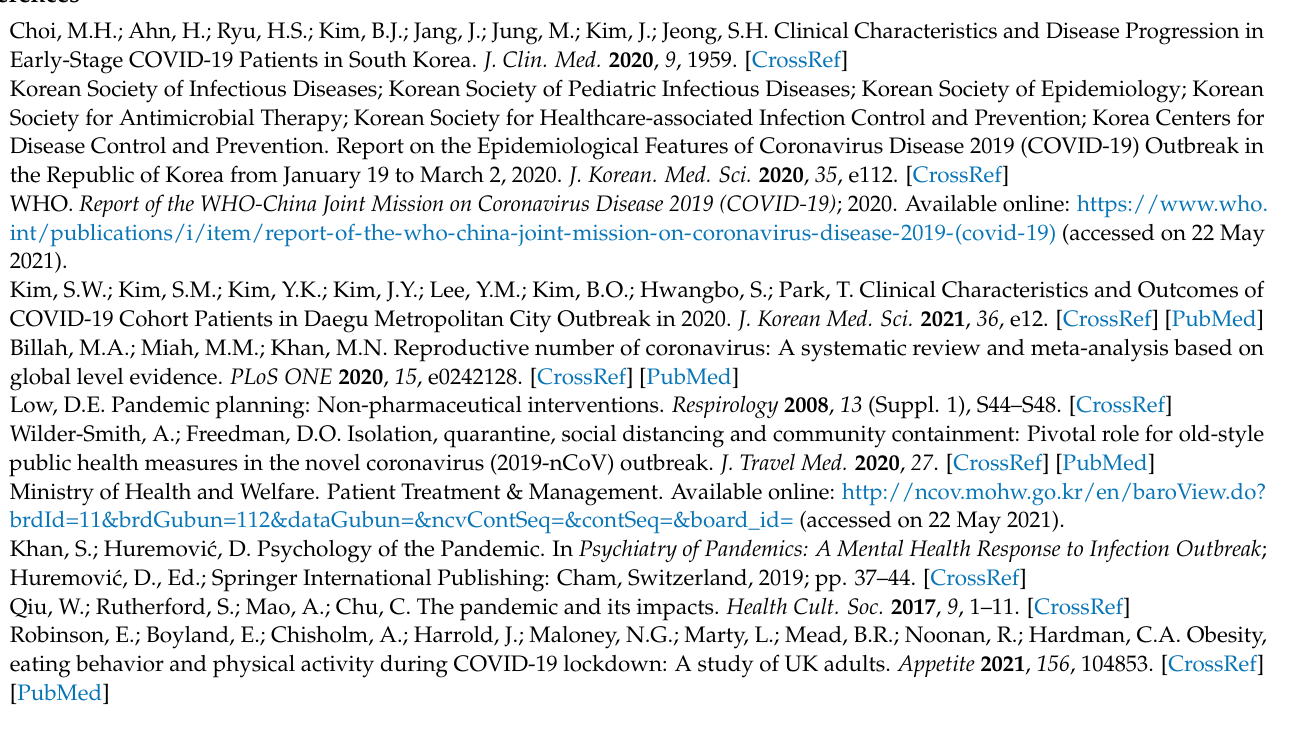
Supplementary Table S3. Needs for confirmed patients and quarantined persons, by sex and age. Supplementary Table S4. Precautionary behavioral survey response results in persons